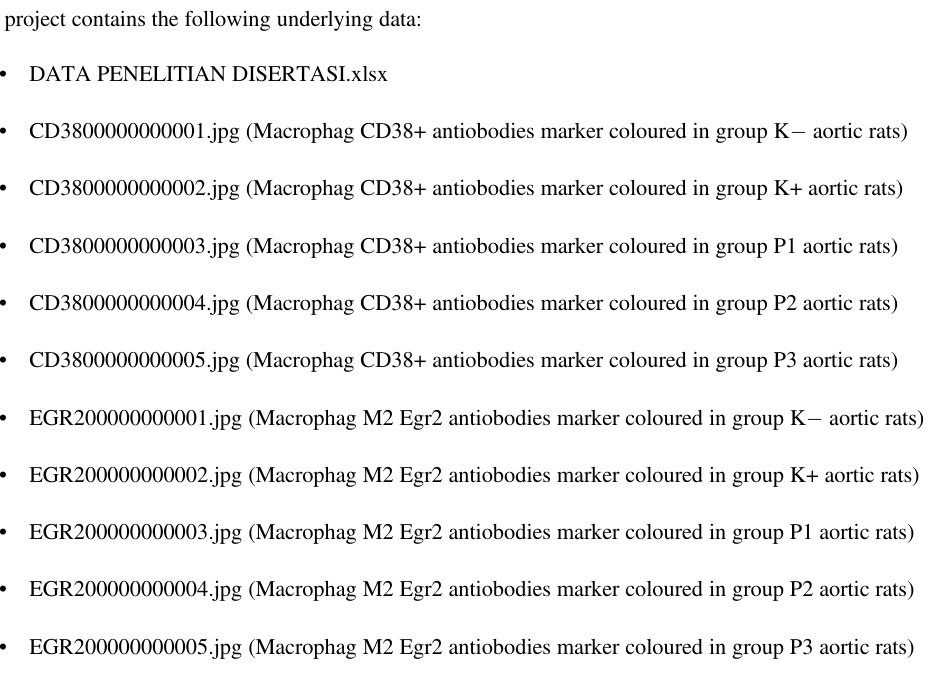
Figshare: Nigella sativa on M1 / M2 Preventive effect of Nigella sativa in M1 / M2 ratio reducing risk of endothelial dysfunction in cigarette smoked